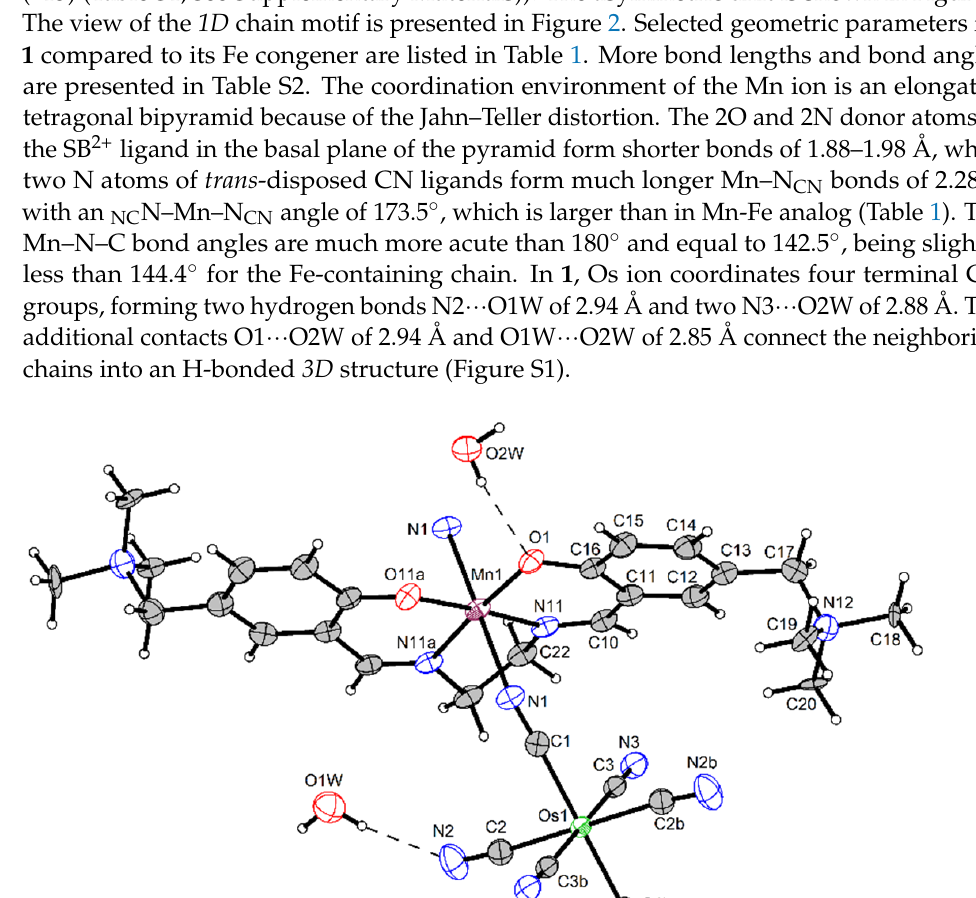
Figure 2. View of the chain motif of 1 projected along a axis. Hydrogen atoms and interstitial water molecules have been omitted for clarity. The axes denote overlap with atoms.